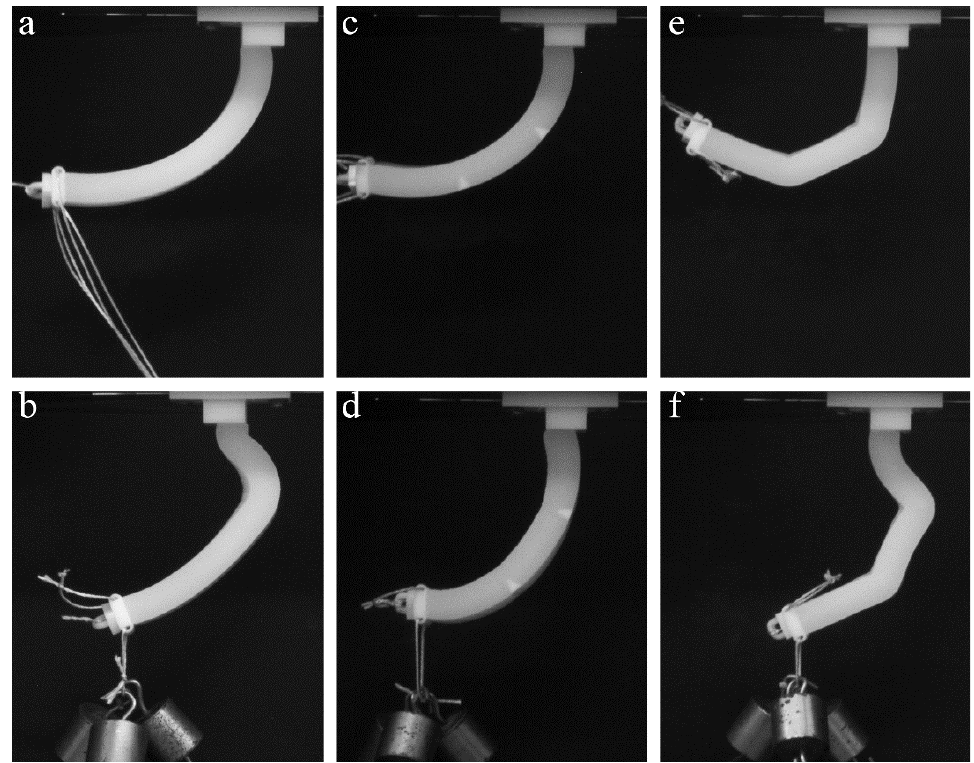
Figure 8. Experimental snapshots for homogeneous FLX9760 actuator ( a , b ), actuators with stiff inserts ( c , d ) and empty notches ( e , f ). Top row corresponds to deformed state without external loading and retraction length 19 mm. Bottom row corresponds to retraction length of 22 mm, while additional 150 g weight was applied on the free end of the actuator.